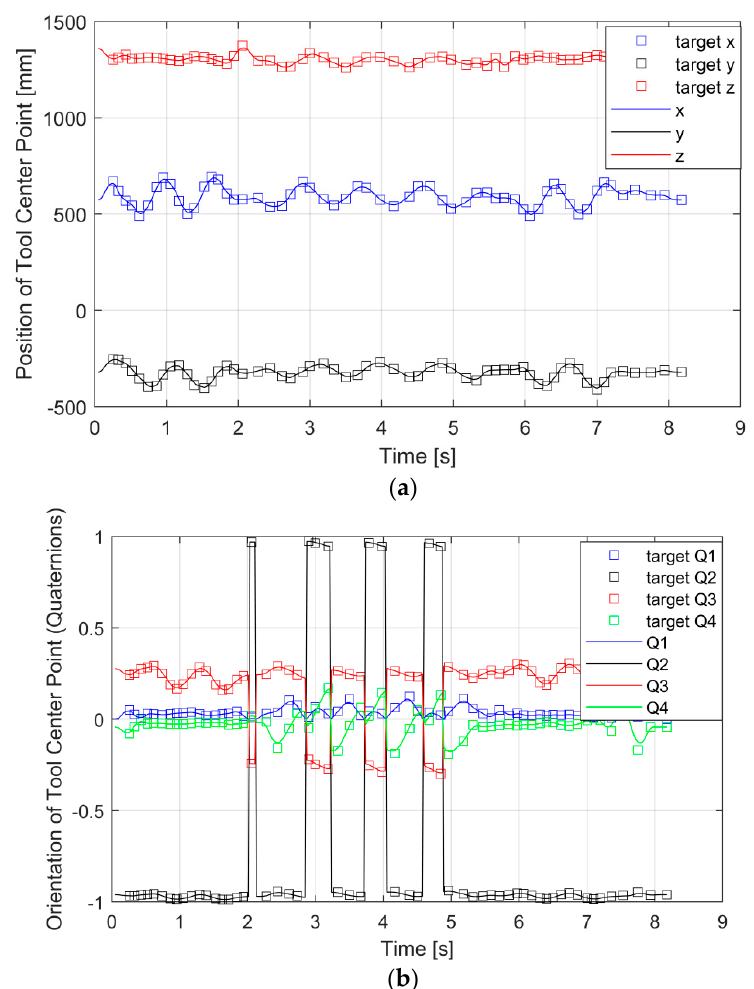
Figure 8. Coordinates of tool center point (TCP) of robots: ( a ) Position; ( b ) orientation expressed in quaternions.